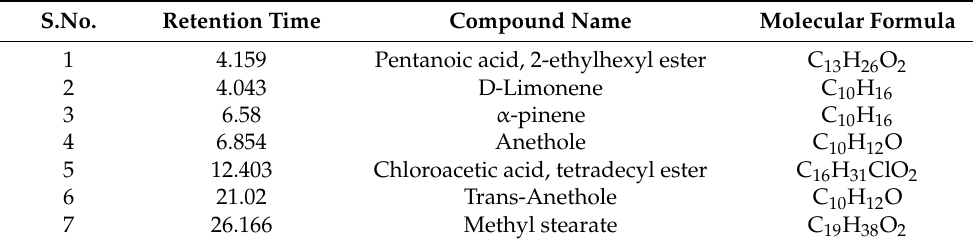
Table 1. GC-MS analysis of CuNPs of star anise.